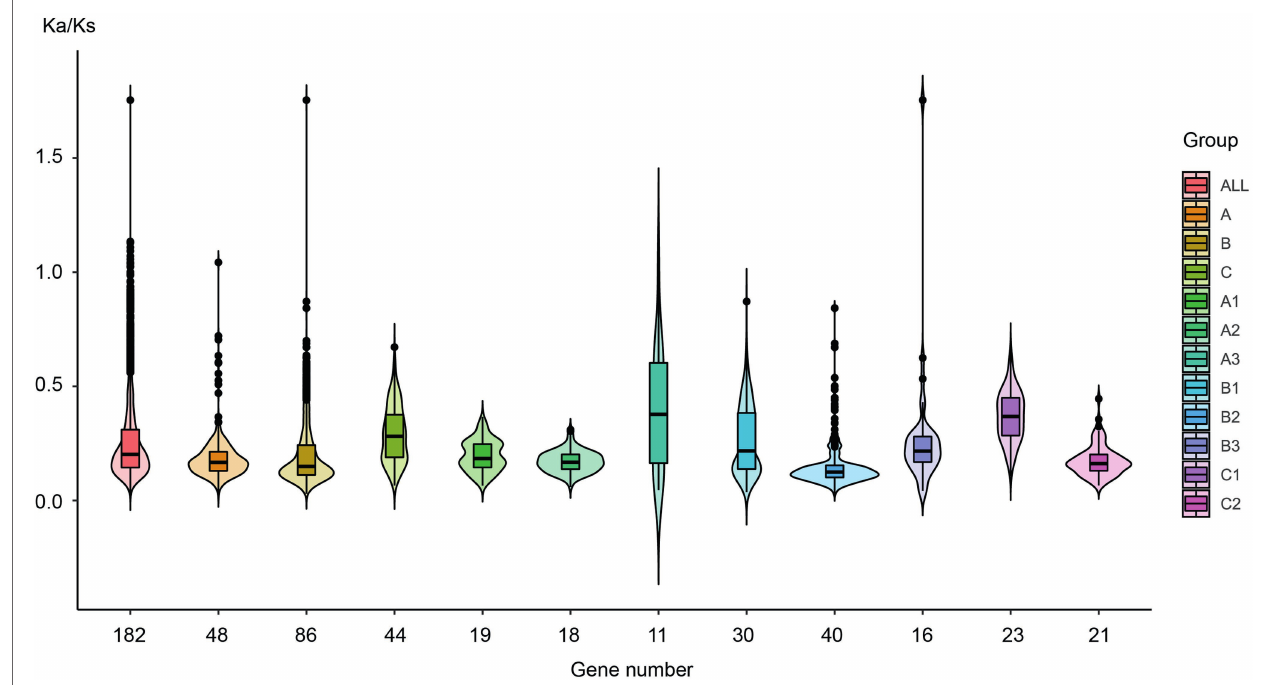
FIGURE 6 | The Ka/Ks value distribution in different plant lineages. Each EIL was compared with the other EILs in the same plant lineage one by one, and the Ka/ Ks value was estimated for each compared pair, and the colors are labeled with the different